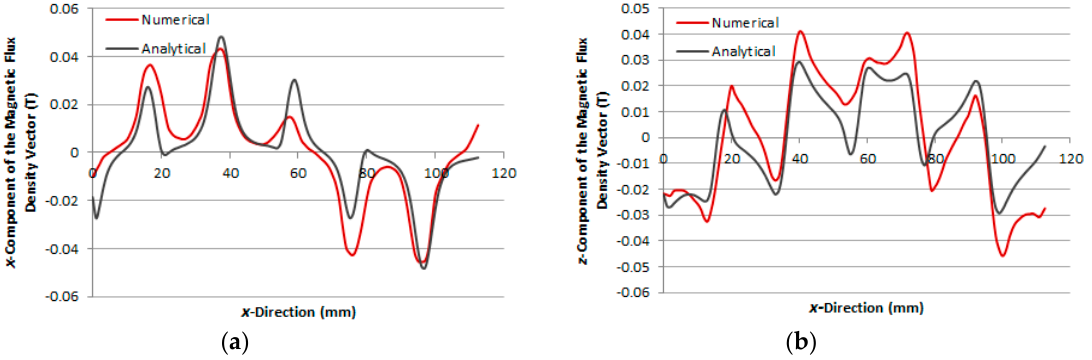
Figure 7. Components of the magnetic flux density vector as a function of x -direction, case 2: ( a ) x -component and ( b ) z -component.